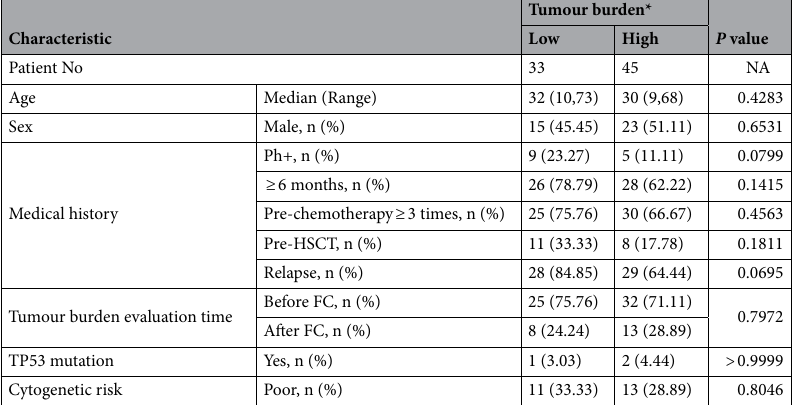
Table 1. Patient and treatment characteristics. Ph+ , Philadelphia chromosome-positive; Pre-HSCT, previous haematopoietic stem cell transplantation; TP53, tumor protein P53; FC, fludarabine and cyclophosphamide. *A high tumor burden was defined as a bone marrow blast level of 5% or more, and a low disease burden was defined as a bone marrow blast level of less than 5%. Minimal residual disease was assessed by multiparameter flow cytometry 25 , and a negative minimal residual disease status was defined as a bone marrow blast level of less than